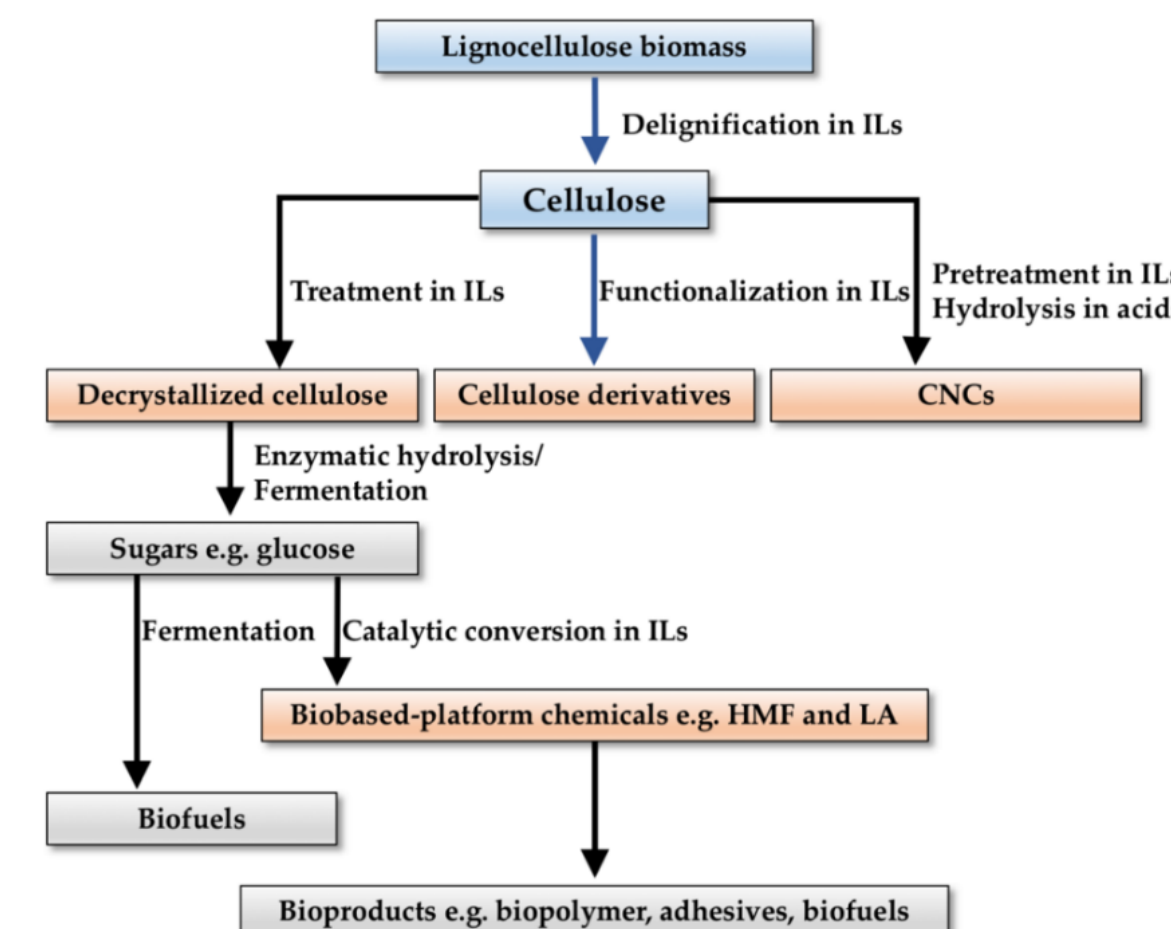
Figure 9. Schematic illustration of the production of bio-based platform chemicals .